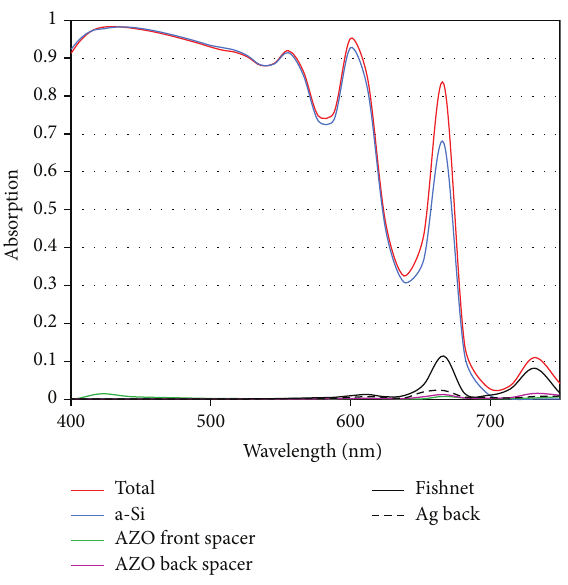
Figure 6: Layer-wise absorption analysis.